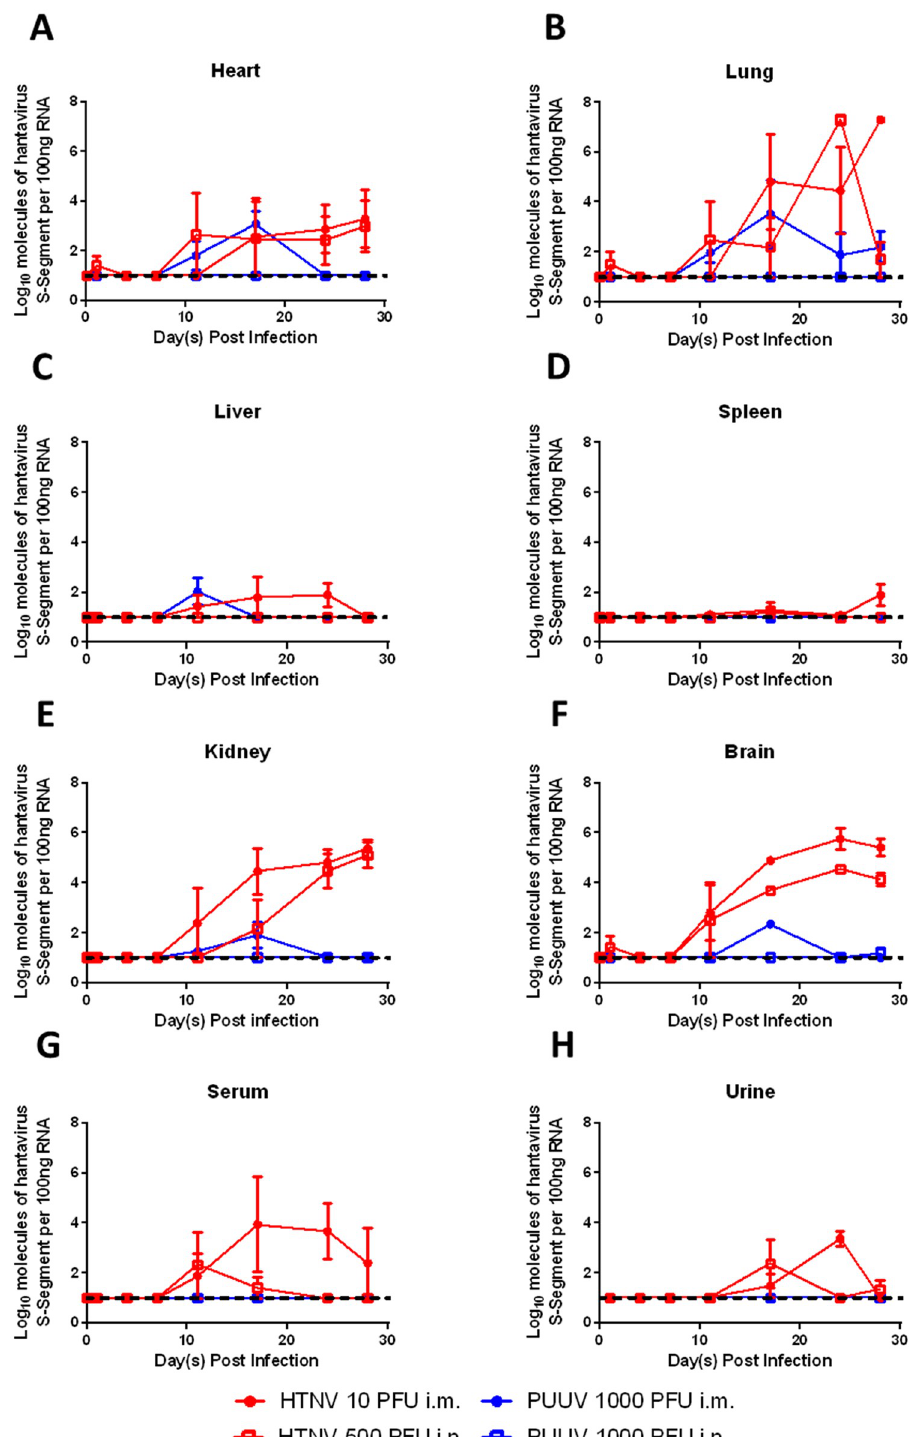
Fig 3. Viral genome is detectable in the organs and sera of infected hamsters. Syrian hamsters were infected either 10 PFU HTNV i.m., 500 PFU HTNV i.n., 1000 PFU PUUV i.m., or 1000 PFU PUUV i.n. Hamsters were euthanized at various points post infection and heart ( A ), lung ( B ), liver ( C ), spleen ( D ), kidney ( E ), brain ( F ), sera ( G ), and urine ( H ) were evaluated by RT-PCR for the presence of viral genome. The mean ± SEM is displayed at each time point. The dashed line indicates the limit of detection (1log 10